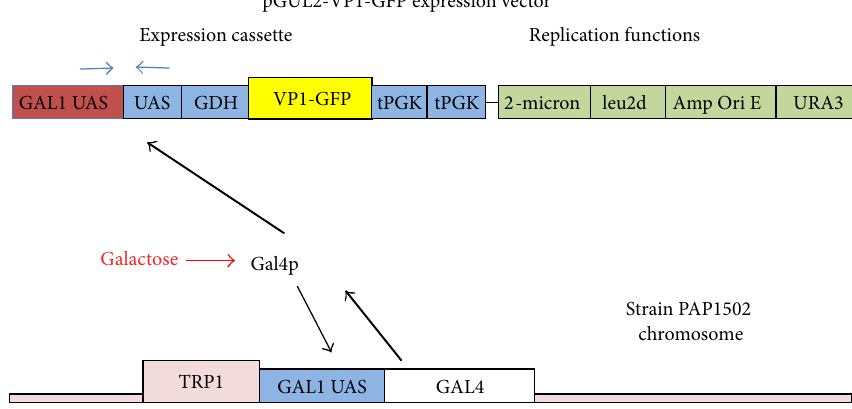
Figure 2: The pGUL2-VP1-GFP expression vector showing the expression cassette and its induction by galactose-induced expression of Gal4p, augmented by overexpression from the GAL1 UAS-driven GAL4 gene inserted at TRP1 in the strain PAP1502 chromosome.